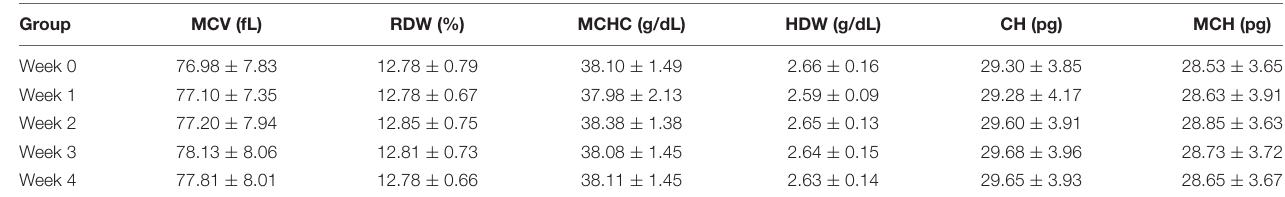
FIGURE 1 | The hematological parameters of the subjects in various weeks. (A) Hemoglobin (Hb); (B) red blood cells (RBCs); (C) hematocrit (Hct) levels. ∗ Significantly different from week 0, P < 0.05. TABLE 1 | Some hematological parameters of subjects during IHE